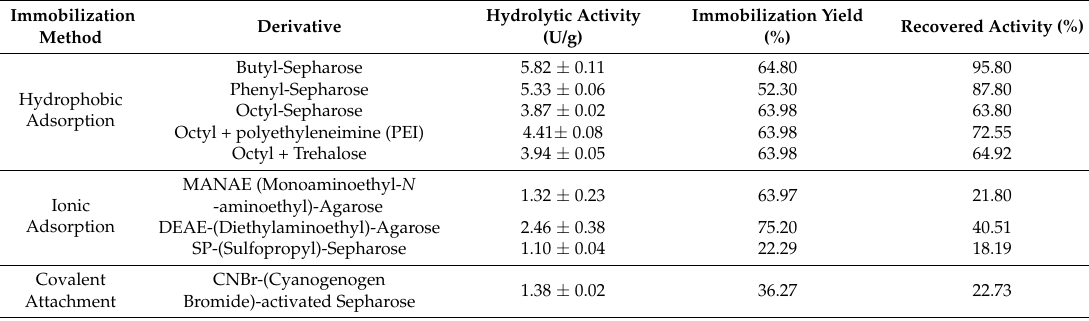
Table 1. Hydrolytic activity and immobilization parameters of M. spathulata R25L270 lipase on different